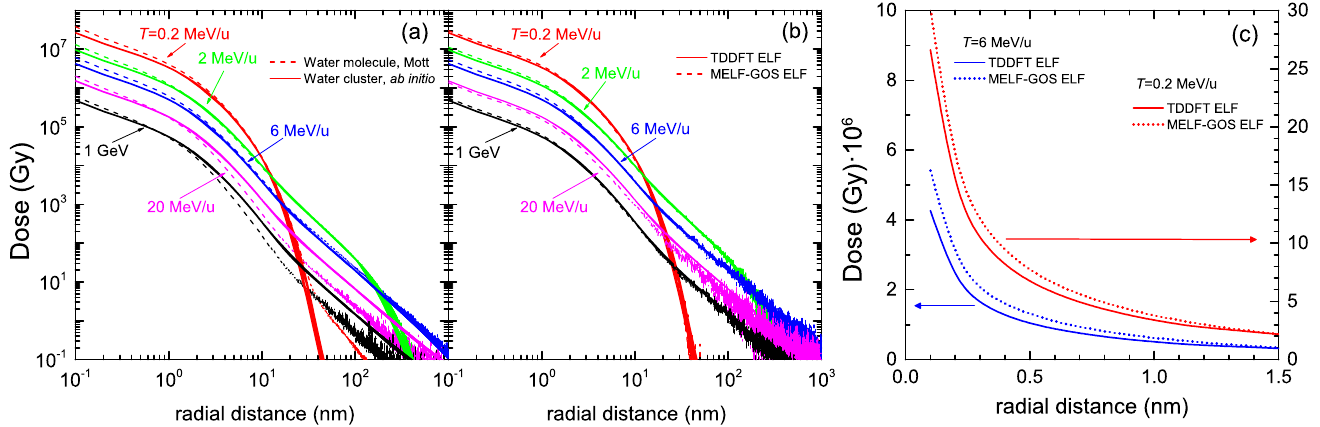
Figure 9. Dose deposited by a carbon ion in liquid water, as a function of the distance from the ion path, for several ion energies T . ( a ) Effect of the elastic scattering models when using Mott’s theory for a single water molecule (dashed lines) and ab initio calculations for a cluster of six water molecules (solid lines). ( b ) Effect of the inelastic scattering models. ( c ) Detail for the different inelastic models at short radial distances. Solid (dotted) curves correspond to simulations using input data from the LR-TDDFT (MELF-GOS) energy loss function. See the text for further